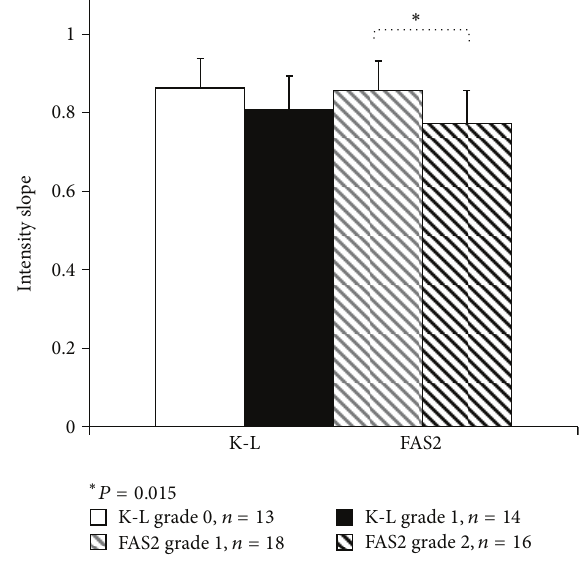
Figure 4: Intensity slopes in different femoral condyles using grouping Kellgren-Lawrence (K-L) grade 0 and 1 and femoral arthroscopic score 2 (FAS2) grade 1 and